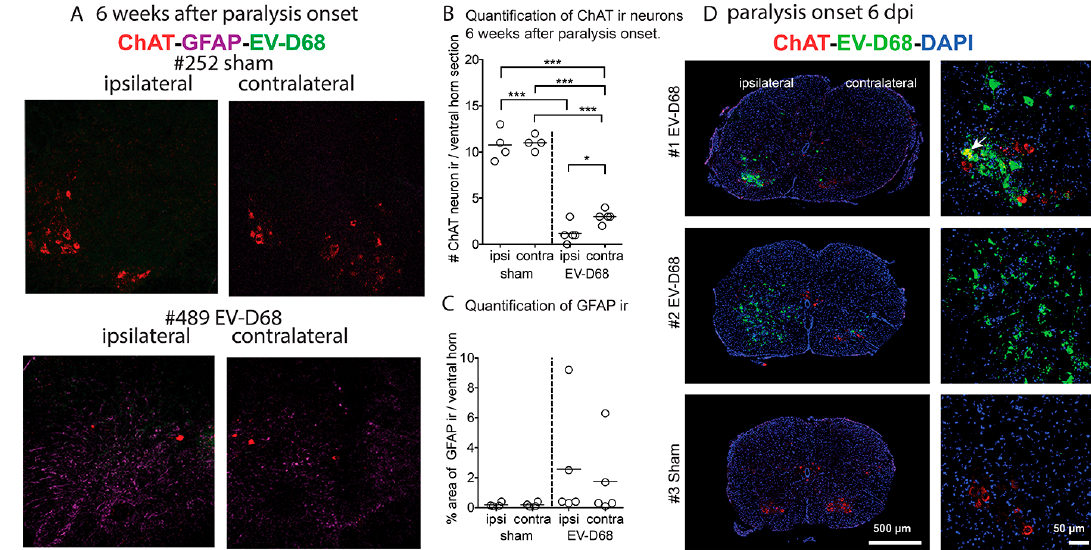
Figure 6. Reduced motor neurons in lumbosacral spinal cords of AG129 mice. ( A ) ChAT ir, GFAP ir, and EV-D68 ir in lumbosacral spinal cords of #252 sham- and #489 EV-D68-infected mice on ipsilateral and contralateral sides (infected i.p. 10 dpi, 6 weeks after paralysis onset); ( B ) Quantification of ChAT ir neurons in ( A , C ); Quantification of GFAP ir in ( A , D ); ChAT ir, EV-D68 ir, DAPI in lumbosacral spinal cord at paralysis onset challenged (six days post-viral injection, dpi) in ( A ). Arrow indicates co-localized EV-D68 ir and ChAT ir. *** p < 0.001 using one-way ANOVA. * p < 0.05 when using t test, but not significant when using one-way ANOVA. Vertical dotted lines separate sham and infected data.